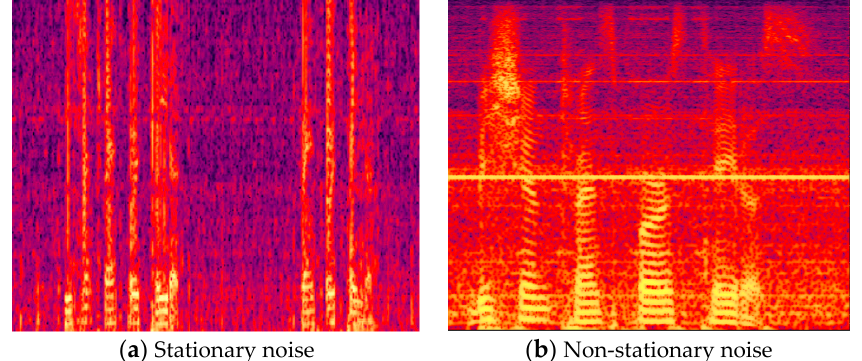
Figure A2. Comparison of speech data contaminated by ( a ) stationary noise in indoor environments and ( b ) non-stationary noise in outdoor environments. These figures represent a two-dimensional spectrogram that describes the spectral energy tendency of speech and non-speech signals with color according to the time (horizontal axis) and frequency (vertical axis) domains.